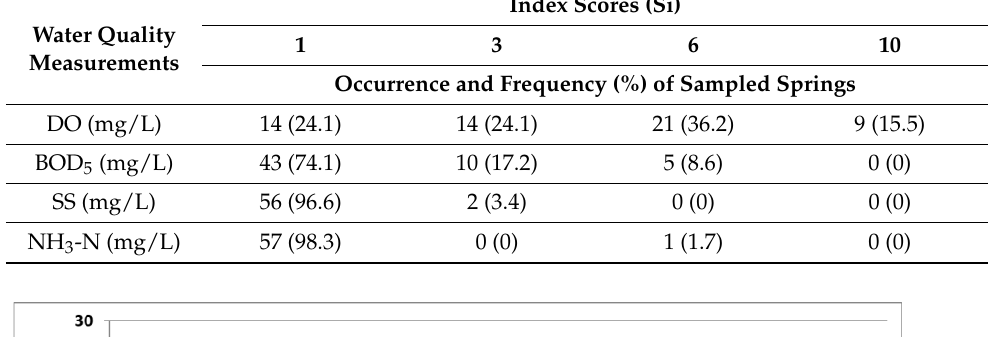
Table 2. The occurrence and frequency of sampled springs in each index score (Si) of four water quality measurements were calculated for the 58 sampled springs. A higher index score indicated a greater polluted status as shown in Table 1.